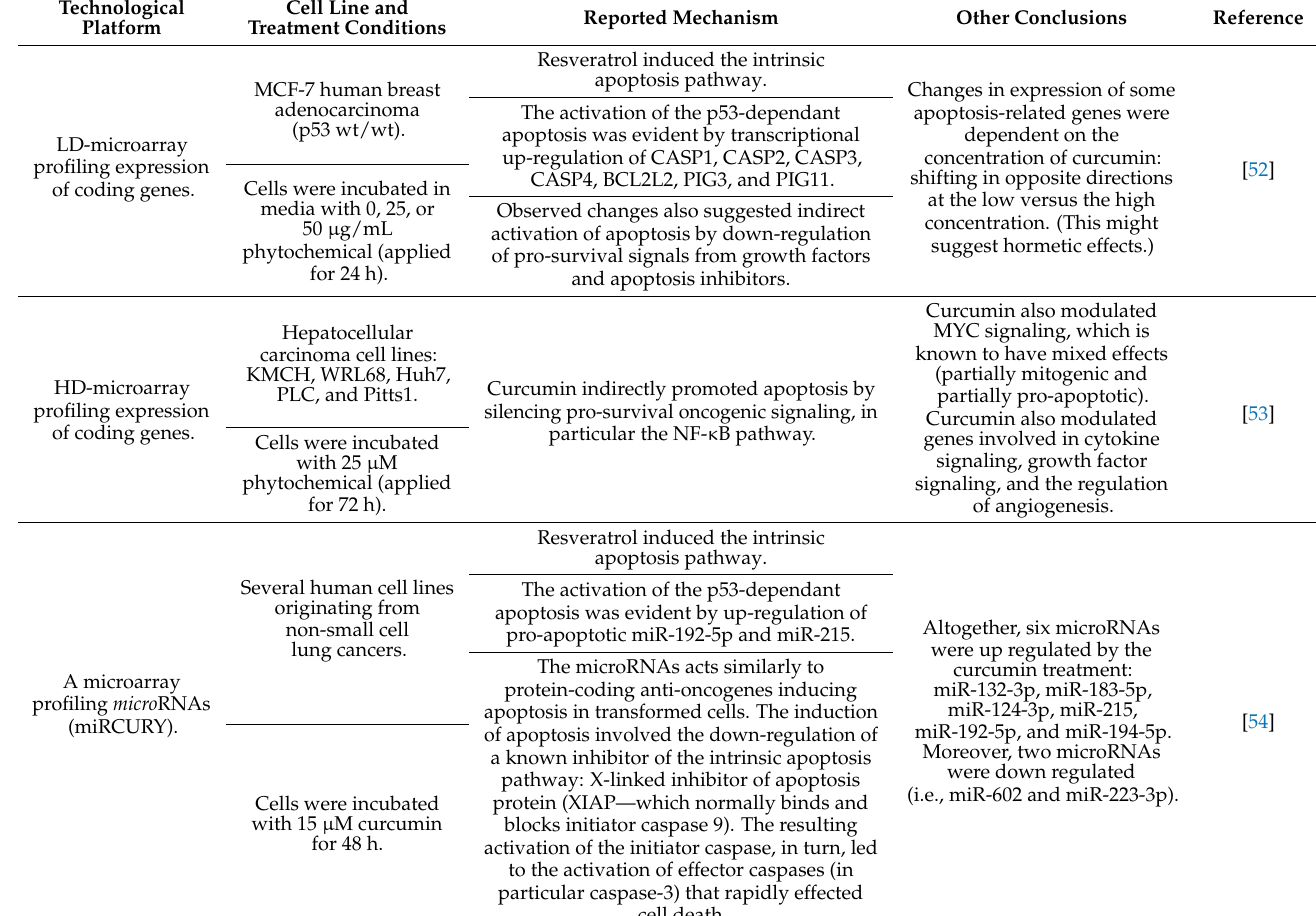
Table 4. There is strong evidence for the activation of the intrinsic apoptosis pathway by